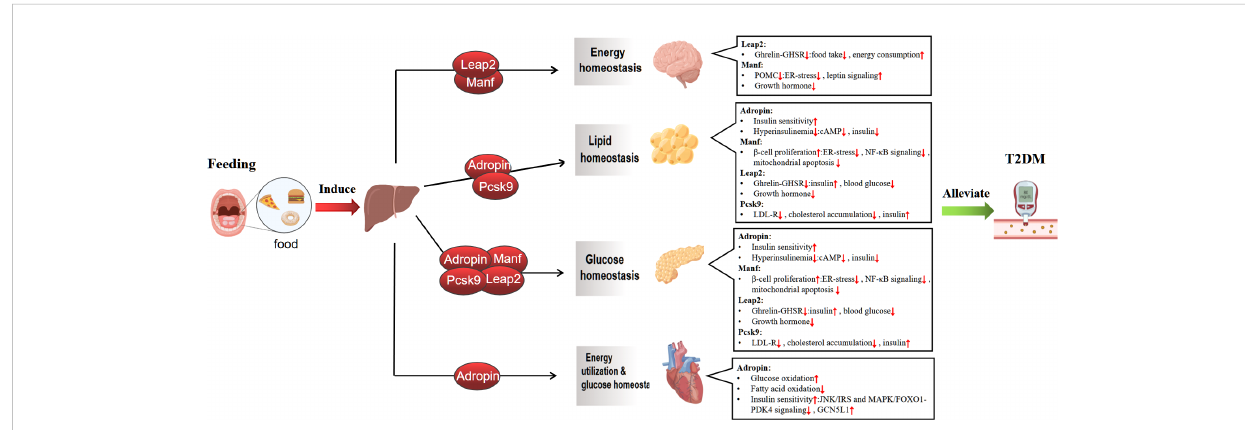
FIGURE 1 Mechanisms offeeding-induced hepatokines amelioration of Type 2 diabetes in target tissues. The liver plays a central role in regulating systemic metabolic homeostasis by sensing nutrient availability and altering metabolite and energy production for use by various organ systems. The act offeeding induces the liver to release hepatokines, which regulate glucolipid metabolism and maintain energy balance by affecting multiple metabolic organs, including the brain, adipose tissue, pancreas and heart, thereby improving type 2 diabete. ↑ increase, ↓ decrease. Graphics from